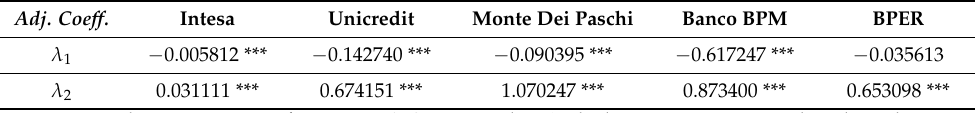
Table 4. VECM adjustment coefficients: period of January 2015–December 2021.